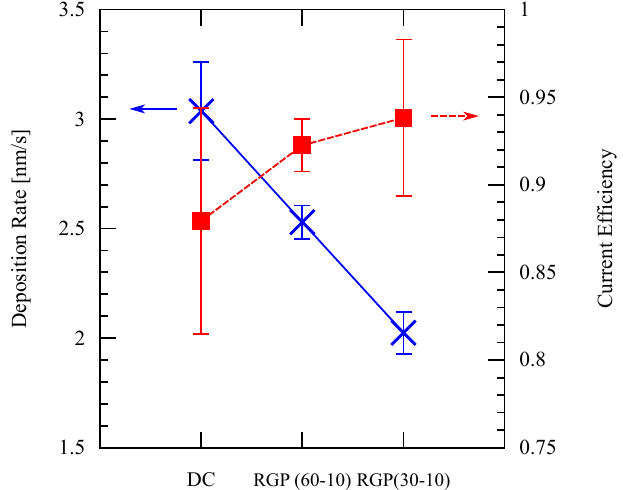
Figure 4. Deposition rate and current efficiency using full DC deposition and different RGP patterns shown in Figure 3. The deposition is performed at room